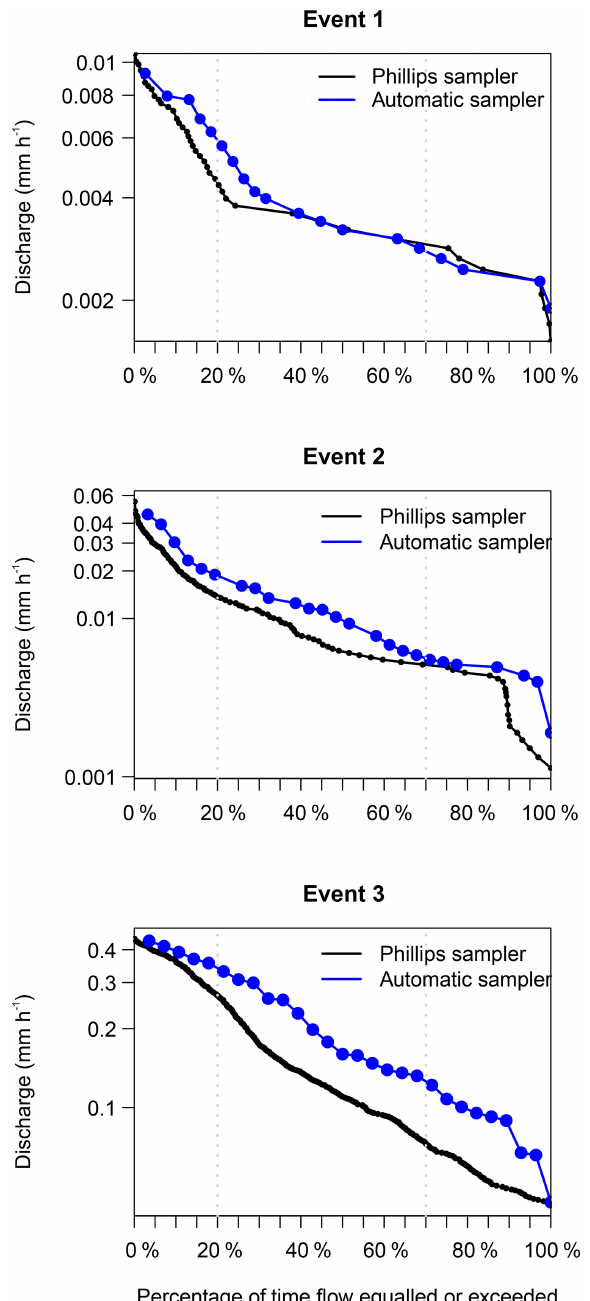
Figure 5. Flow duration curves covering the sampling period of the Phillips samplers. The blue line shows the samples taken with an automatic sampler for diatom analysis, and the black line shows the continuous measurements of discharge at 15min intervals.